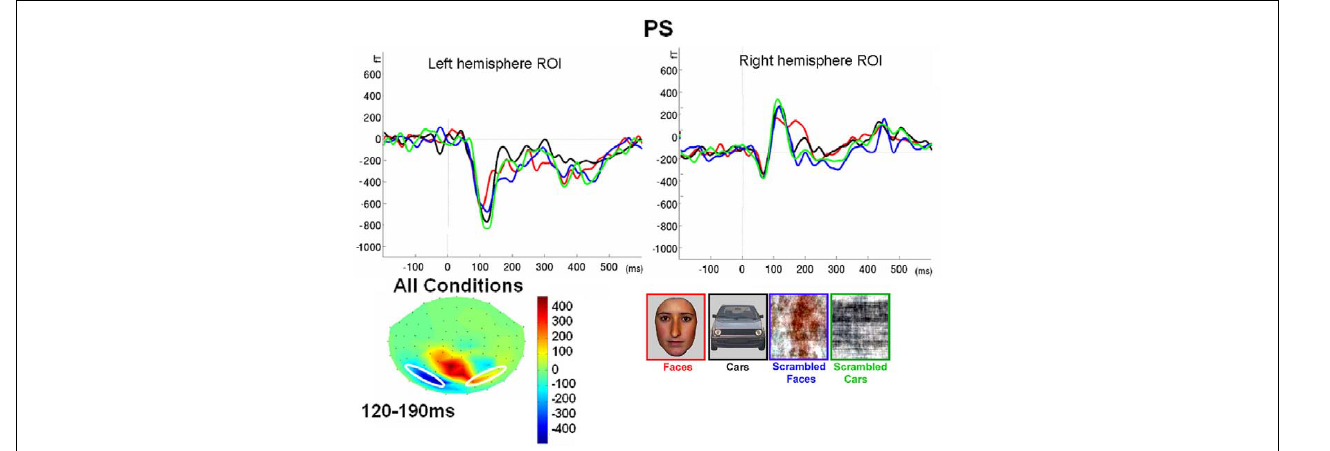
to 190ms, averaged across conditions, highlighted in white on topography below (these are Neuromag channels “MEG2521,” “MEG2321,” and “MEG2341” for the right ROI, and “MEG1641,” “MEG1941,” and “MEG1921” for the left ROI).